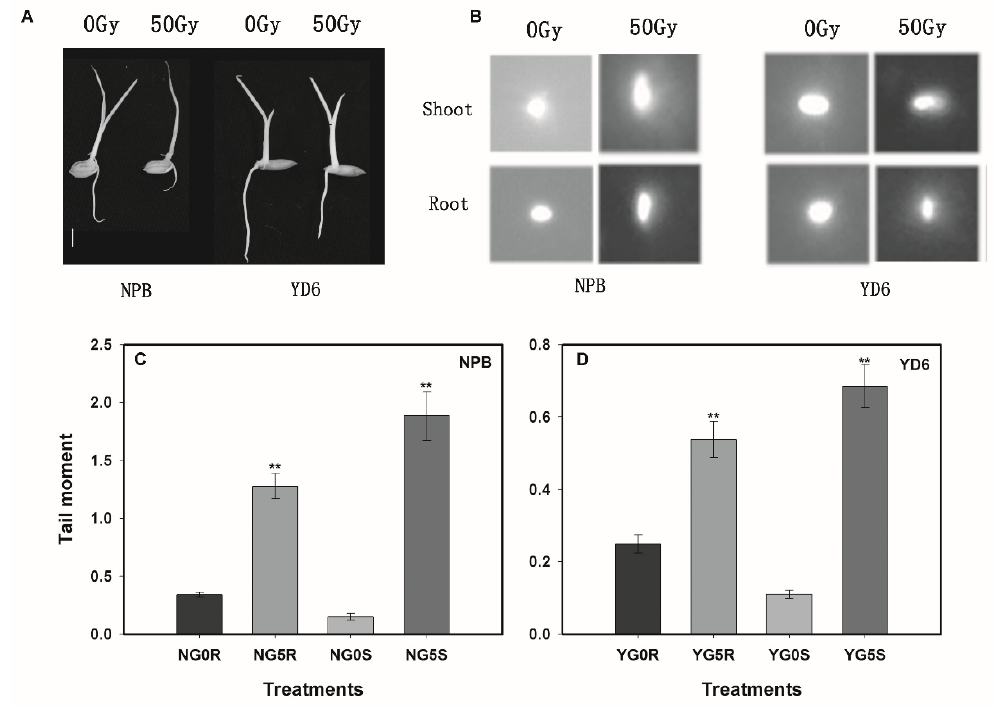
Figure 3. Comet assay of shoot and root cells. ( A ) Morphological characteristics of seedlings of NPB and YD6. Bar = 1 cm; ( B ) nuclei collected from shoot and root of NPB and YD6 treated with 0 Gy and 50 Gy; ( C ) the tail moment values of NPB. NG0R and NG0S, the control (0 Gy) of root and shoot in NPB, respectively. NG5R and NG5S, the irradiation treatment (50 Gy) of root and shoot in NPB, respectively; ( D ) the tail moment values of YD6. YG0R and YG0S, the control of root and shoot in YD6, respectively. YG5R and YG5S, the irradiation treatment of root and shoot in YD6, respectively. ** ( p ≤ 0.01) indicates significant difference compared to control.